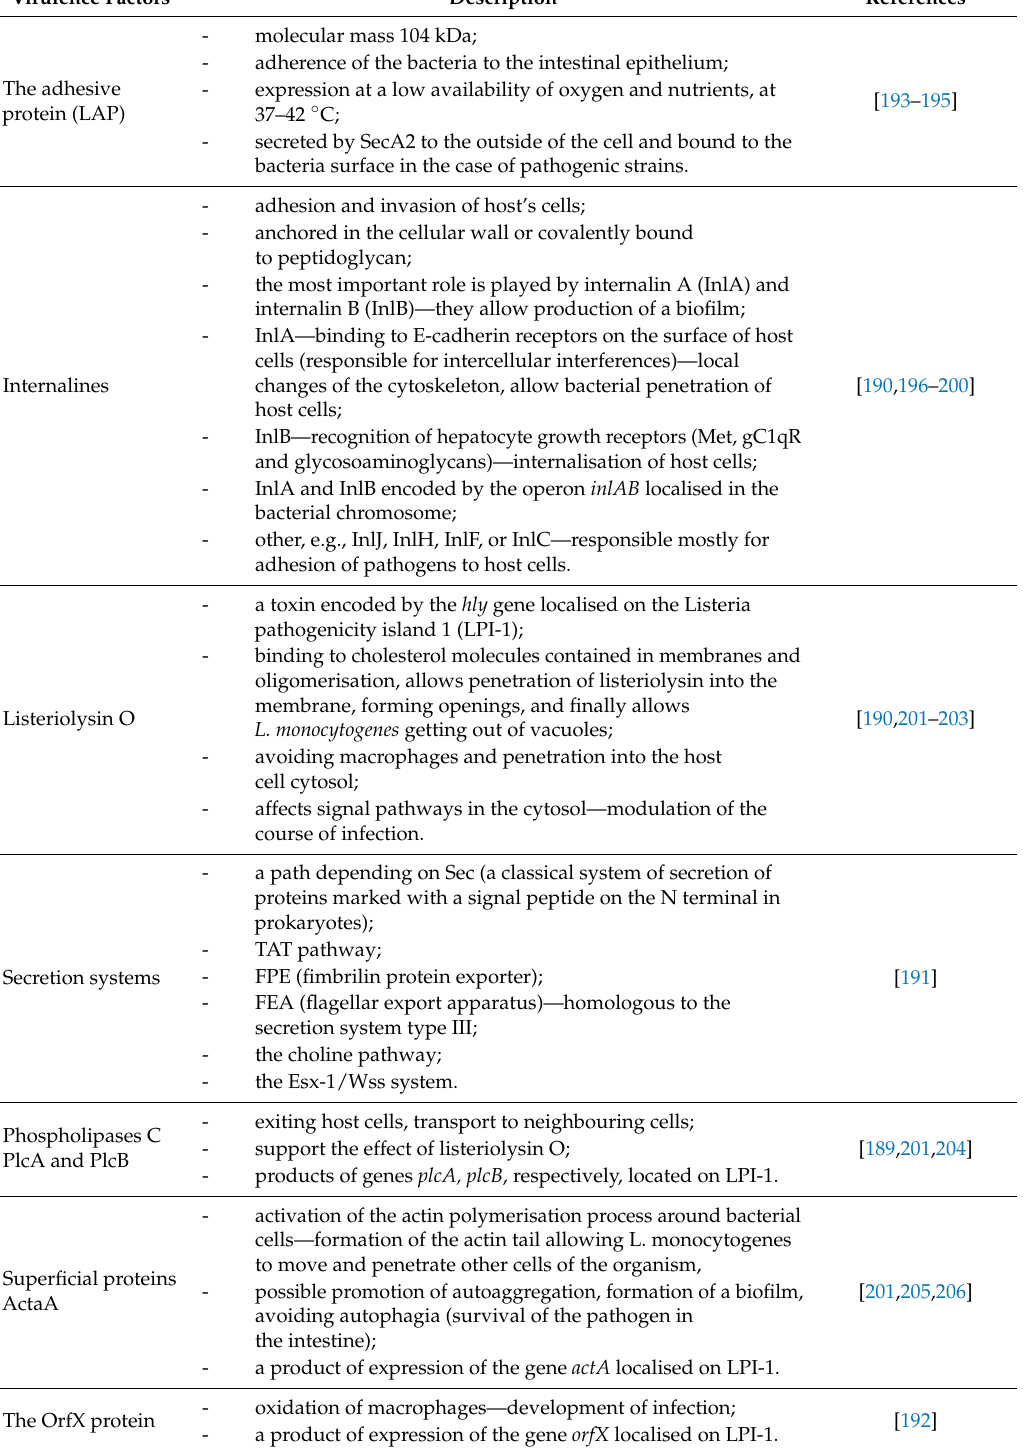
Table 5. Factors determining the pathogenicity of Listeria monocytogenes